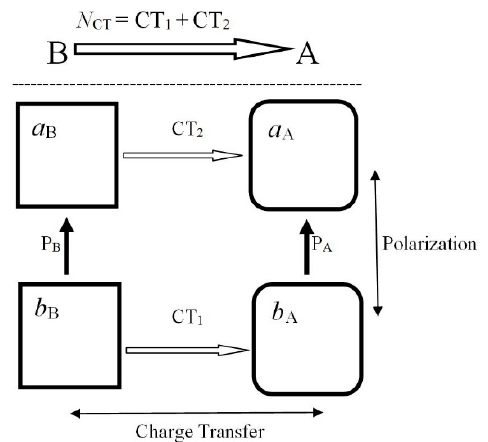
Figure 6. Polarizational {P α = ( b α → a α )} and charge-transfer, CT 1 = ( b B → b A ) and CT 2 = ( a B → a A ), electron flows, involving the acidic A = ( a A | b A ) and basic B = ( a B | b B ) reactants in the regional HSAB complex R HSAB , in which the chemically hard (acidic) and soft (basic) fragments of one reactant coordinate to the like fragment of the other substrate. The two partial {CT i } fluxes (white arrows) now generate a moderate overall B → A transfer of N CT = CT 1 + CT 2 electrons between the mutually open reactants. These hypothetical electron flows in the regional HSAB complex are seen to produce a disconcerted pattern of fluxes producing an exaggerated outflow of electrons from b B and and their accentuated inflow to a A .